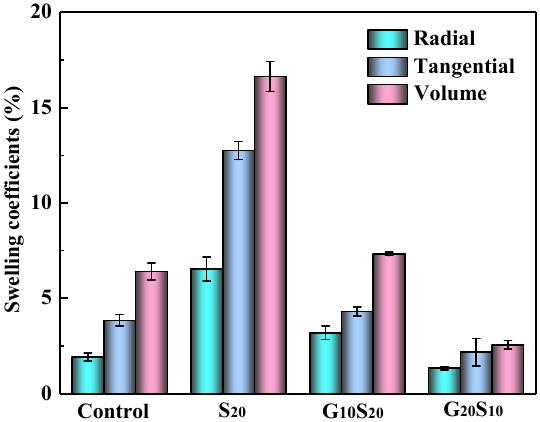
Figure 3. Swelling rate of the modified wood. Table 2. Anti-swelling efficiency (%) of the modified wood.